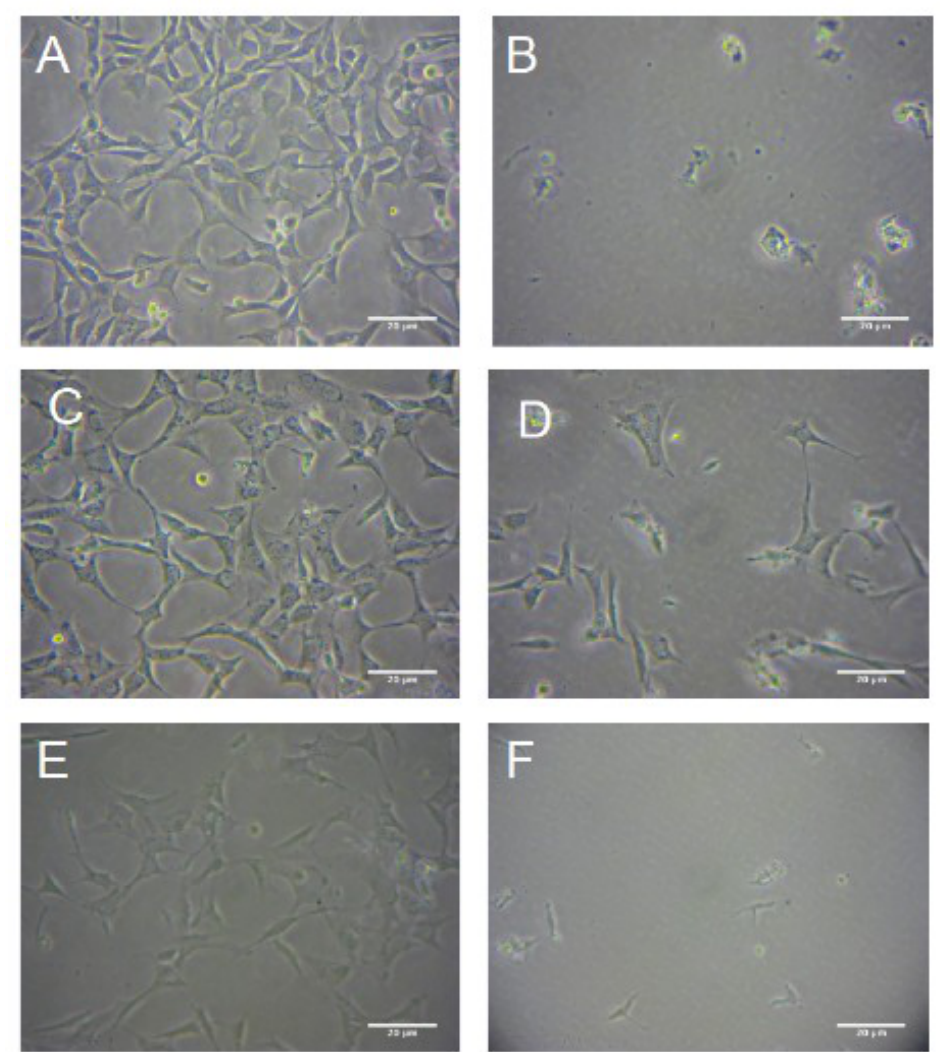
Figure 5. The protective effects of R. nautus against cell death caused by 18-hour hypoxia and 6-hours reoxygenation. HT-22 Cell cultured in 6 well culture plates at a density of 10 5 cells per well and photographed using a soligor microscope adaptor tube for Canon A650 with the Austria micros microscope 10 × objective and 6 × zoom on the camera. (A). HT-22 cells subjected to normoxic conditions cells; ( B ). Untreated HT-22 cells subjected to hypoxia 18-hours, reoxygenation 6-hours; ( C ). HT-22 cells pre treated with 10 µg mL − 1 R. nasutus subjected to 18-hours of hypoxia and 6-hours of reoxygenation; ( D ). HT-22 Cells pretreated with 1 µg mL − 1 R. nasutus subjected to 18-hours of hypoxia and 6-hours of reoxygenation; ( E ). HT-22 cells treated with 10 µg mL − 1 R. nasutus at the time of being subjected to 18-hours of hypoxia and 6-hours of reoxygenation; ( F ). HT-22 cells treated with 1 µg mL − 1 R. nasutus at the time of being subjected to 18-hours of hypoxia and 6-hours of